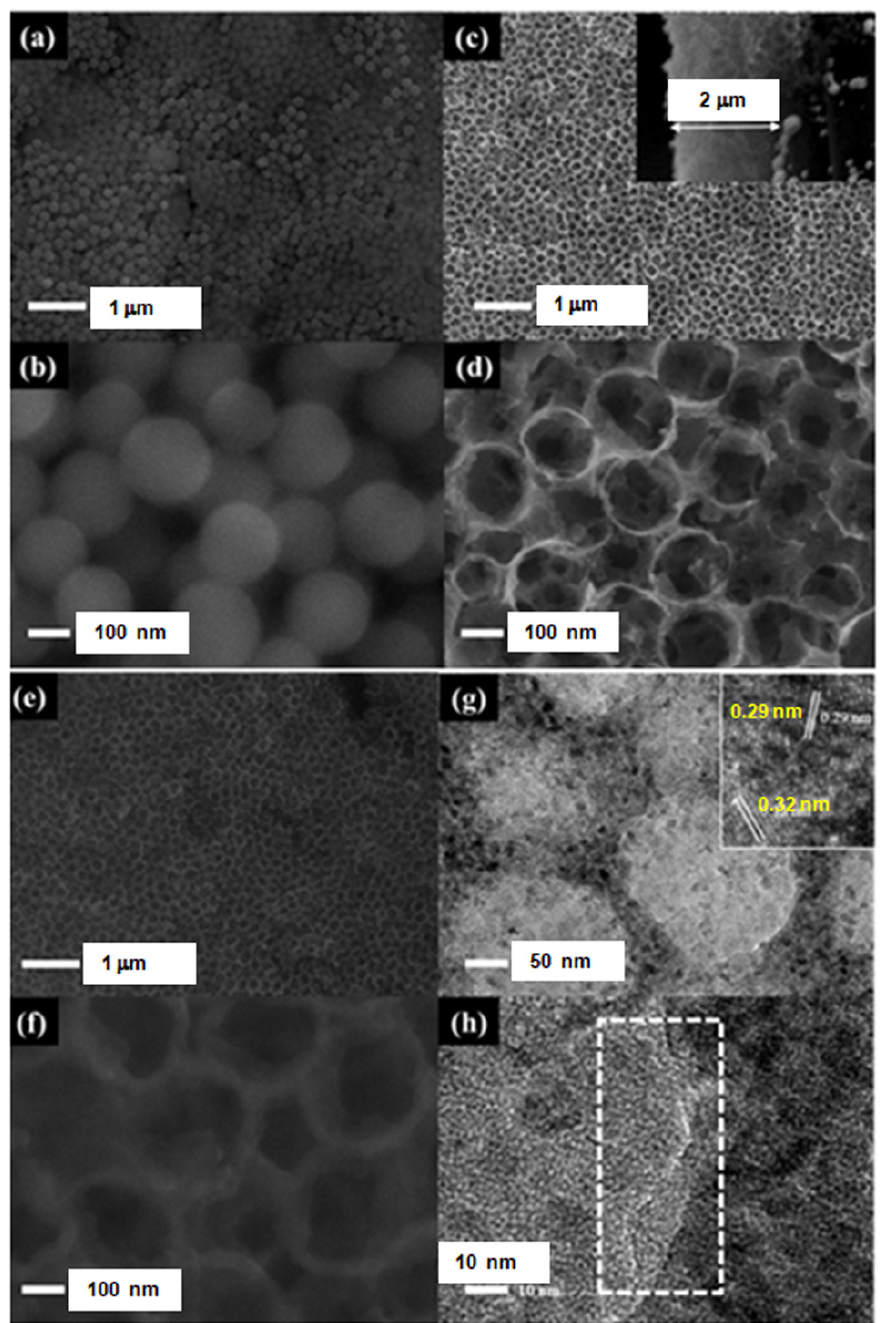
Figure 3 Figure 3. SEM images with various magnifications of SiO 2 spheres modified CP ( a , b ), porous TiO 2 modified CP ( c , d ), porous TiO 2 @C modified CP ( e , f ), and TEM images with various magnifications of TiO 2 @C ( g , h